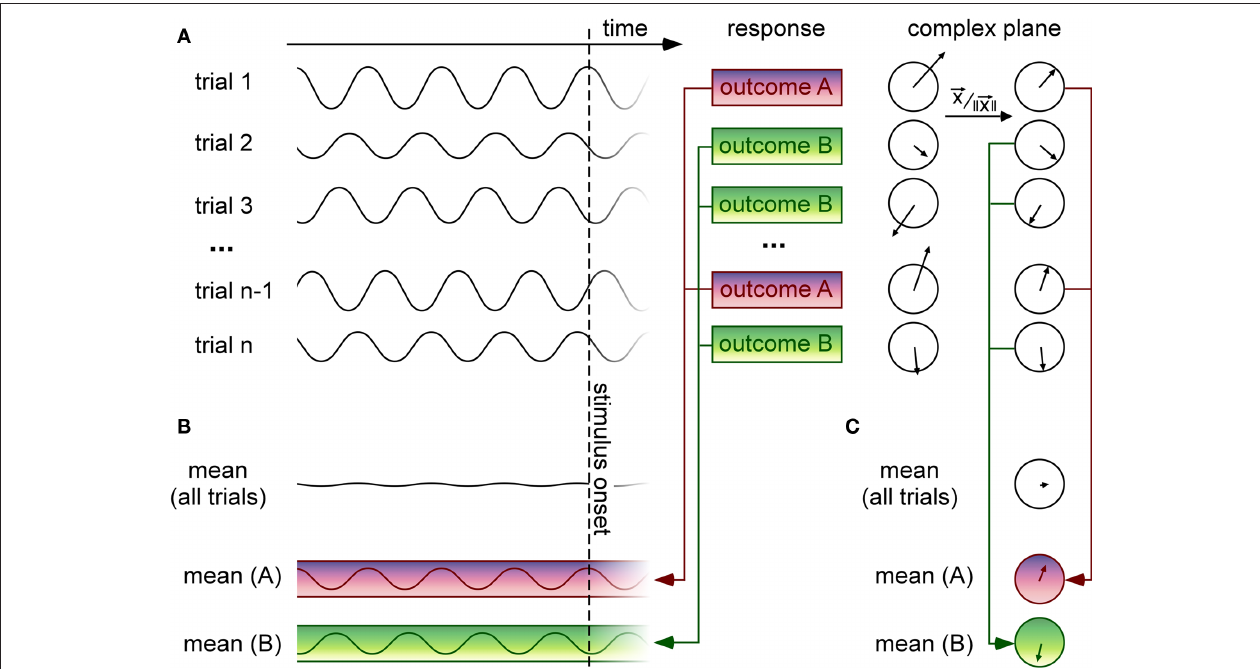
FiGurE 1 | Methods for linking pre-stimulus EEG phase to trial-by-trial variations of a discrete behavioral response. (A) On each trial, a time-varying signal (such as an EEG waveform) is recorded before stimulus onset. Here the signal is represented as oscillatory, but it could also correspond to a band-pass filtered version of a noisy, non-oscillatory signal. For each trial, the observer provides a behavioral response with discrete outcomes [here two possible outcomes (A,B) ] corresponding, e.g., to distinct percepts (seen vs. unseen, category (A vs. B) ], or to quantized reaction times (e.g., slow vs. fast), etc. On the right, the time-domain signal recorded on each trial is expressed as a vector in the complex plane (which can be calculated using Fourier or wavelet time–frequency decomposition methods). The direction of the vector and its length represent the phase and the amplitude (respectively) of the oscillatory signal recorded in a given time window of interest. (B) Since the moment of stimulus onset is unpredictable, the pre-stimulus mean over all trials is near-zero. However, if certain oscillatory phases systematically induce one or the other behavioral outcomes, then selectively averaging the signals for trials grouped according to the behavioral response should reveal oscillations with distinct phase angles. Here the